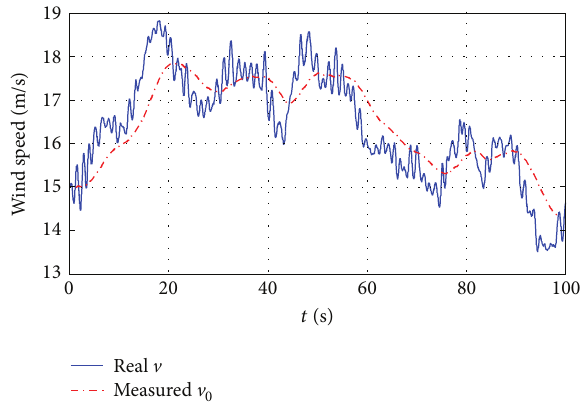
Figure 12: Real and measured wind speed.